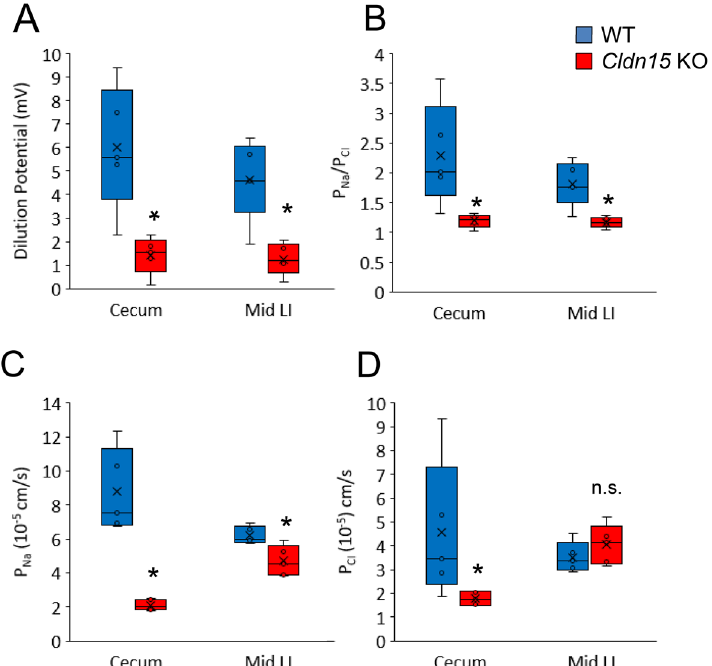
Figure 7. The relative permeability of Na + is reduced in the cecum and proximal and middle large intestine of claudin-15 KO mice. The cecum and middle large intestine were prepared and mounted in Ussing chambers. ( A ) Transmural potential difference (∆mV) after dilution of NaCl on the mucosal side in the cecum and middle large intestine. ( B ) The relative permeability of Na + in the cecum and middle large intestine. ( C ) The permeability of Na + (P Na ) and ( D ) Cl − (P Cl ) in the cecum and middle large intestine of Cldn15 KO mice. The box plots represent the minimum, first quartile, median, third quartile, and maximum values, the mean is marked with an X, n = 5. Statistical significance from left to right: ( A ) *P = 0.008; *P = 0.016; ( B ) *P = 0.016; *P = 0.016; ( C ) *P = 0.008; *P = 0.032; ( D ) *P = 0.032; n.s. P = 0.421, Mann–Whitney U test, Cldn15 KO vs. WT. Please see supplementary table 4 for data